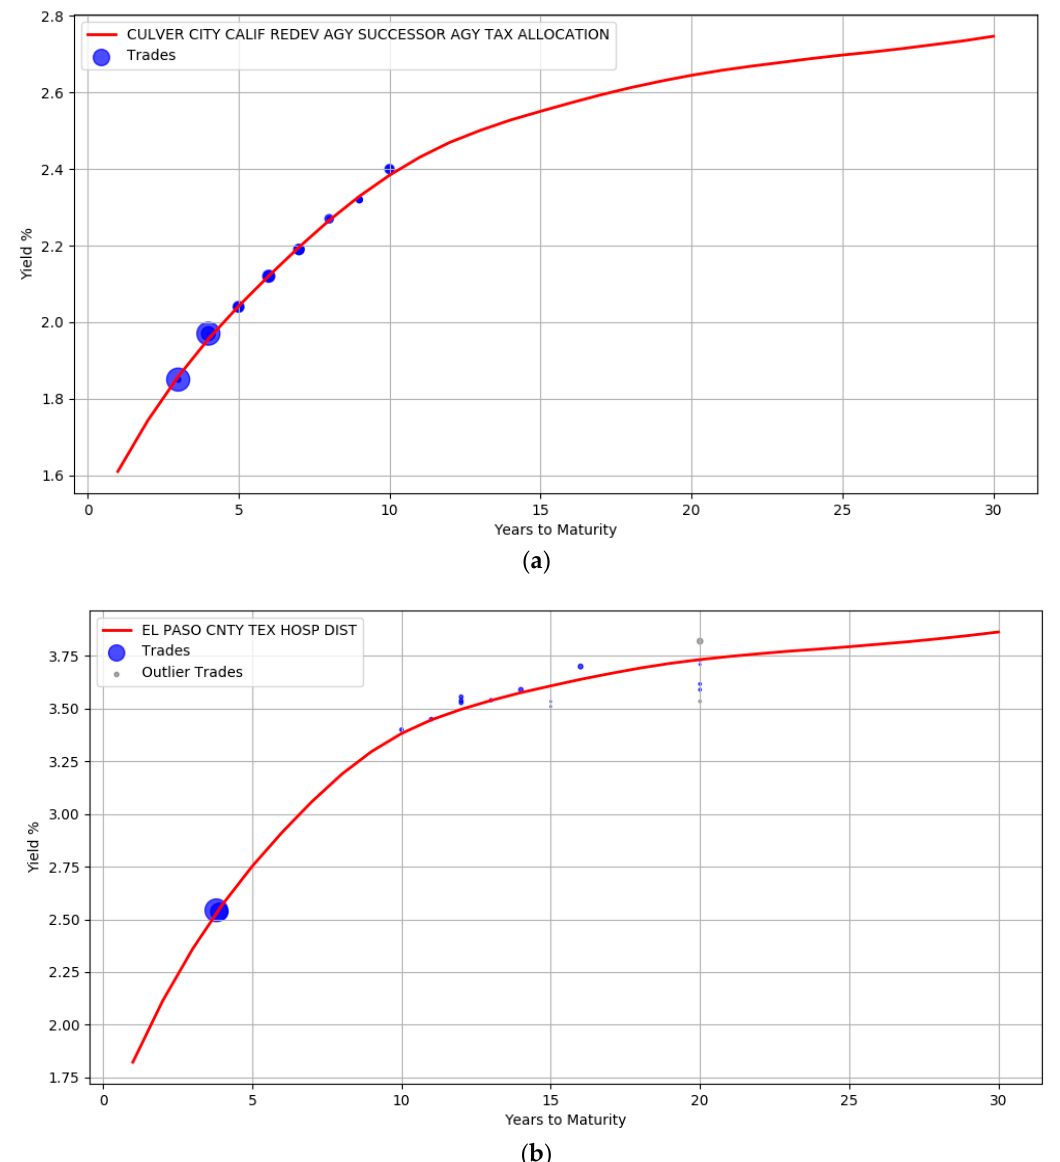
Figure 4. Robustness to sample size. Yield curves for issuers with very few trade samples and devoid of trades at the left and right boundaries. ( a ): Culver City California. ( b ): El Paso County hospital.